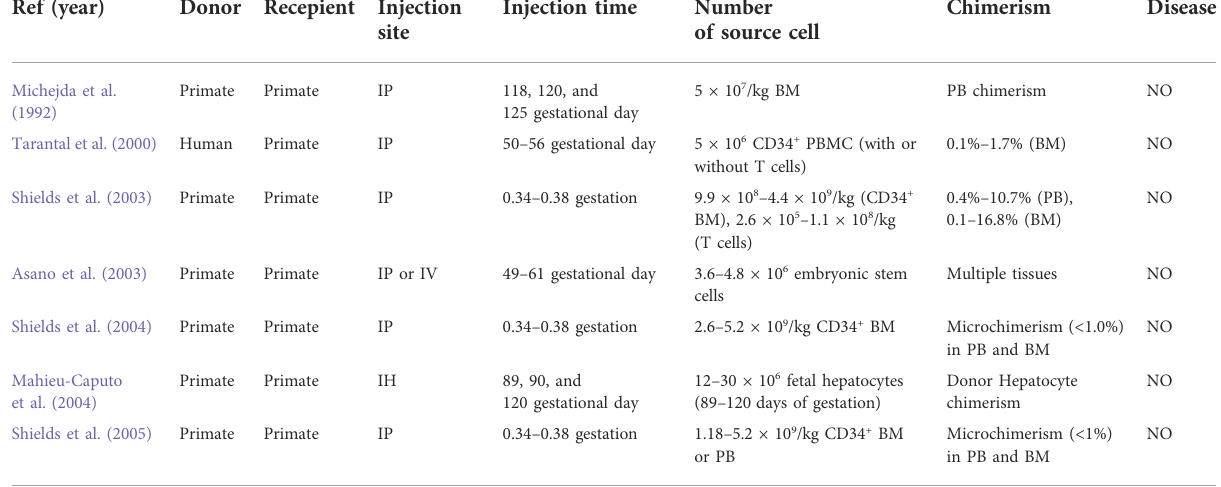
TABLE 5 IUT in primate